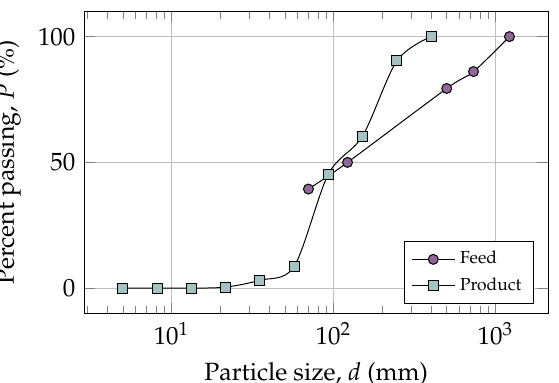
Figure 8. DEM simulated feed and product particle size distributions. The feed is common for all the simulations, and the product is for the base